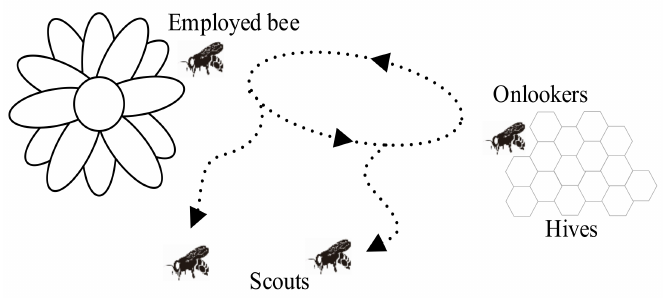
Figure 1. Schematic diagram of collecting nectar of bee